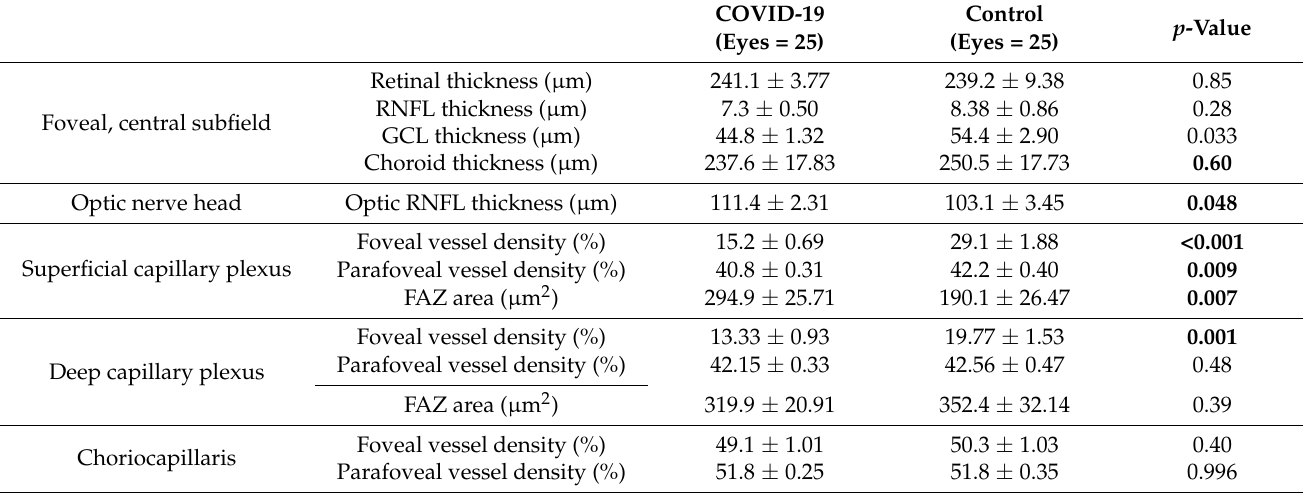
Figure 4. Structural optical coherence tomography (OCT) analysis, optic nerve head. Mean thickness in microns of the retinal nerve fiber layer (RNFL). Left p -values correspond to a comparison between COVID-19 patients and controls. Right p -values correspond to a comparison between COVID-19 patients with cotton wool spots (CWS) and without CWS. Error bars correspond to the SEM. * p < 0.05. Table 2. Comparison of structural optical coherence tomography (OCT) and OCT angiography (OCTA) parameters in COVID-19 patients and age-, sex-, and laterality-matched controls. Mean ± SEM (standard error of the mean) structural OCT and OCTA values. Retinal nerve fiber layer (RNFL), ganglion cell layer (GCL), superficial capillary plexus (SCP), foveal avascular zone (FAZ), deep capillary plexus (DCP), and choriocapillaris (CC). p -values correspond to a comparison between subgroups. Bold values denote statistical significance at the p < 0.05 level.